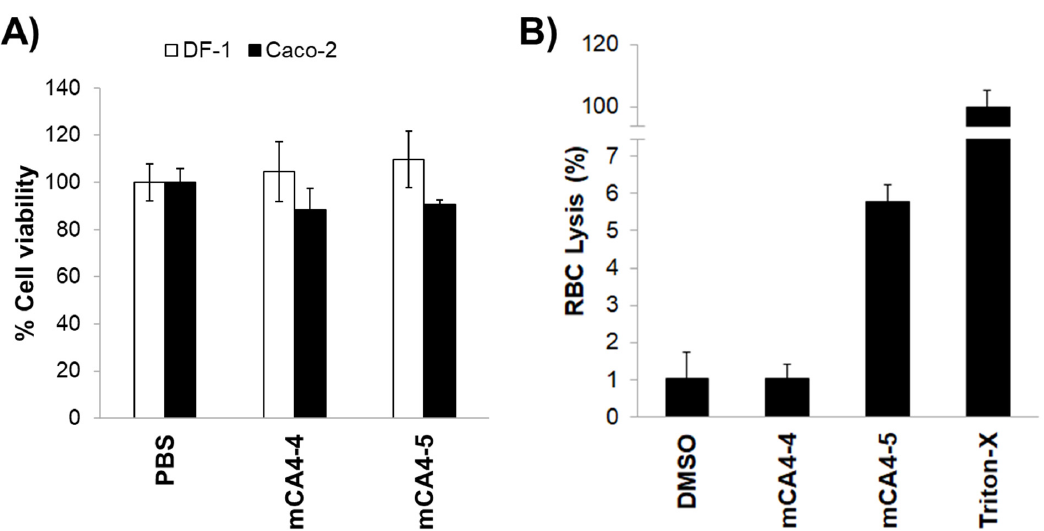
Figure 1. ( A ) Cell viability of DF-1 fibroblasts and Caco-2 cells upon incubation with 100 µ M peptides for 24 h; ( B ) percentage hemolysis in red blood cells upon treatment with 100 µM peptides for 4 h. Error bars indicate the standard deviation of triplicates. DMSO is used as a negative control and Triton-X100 is used as a positive control and indicate 100% red blood cell lysis.